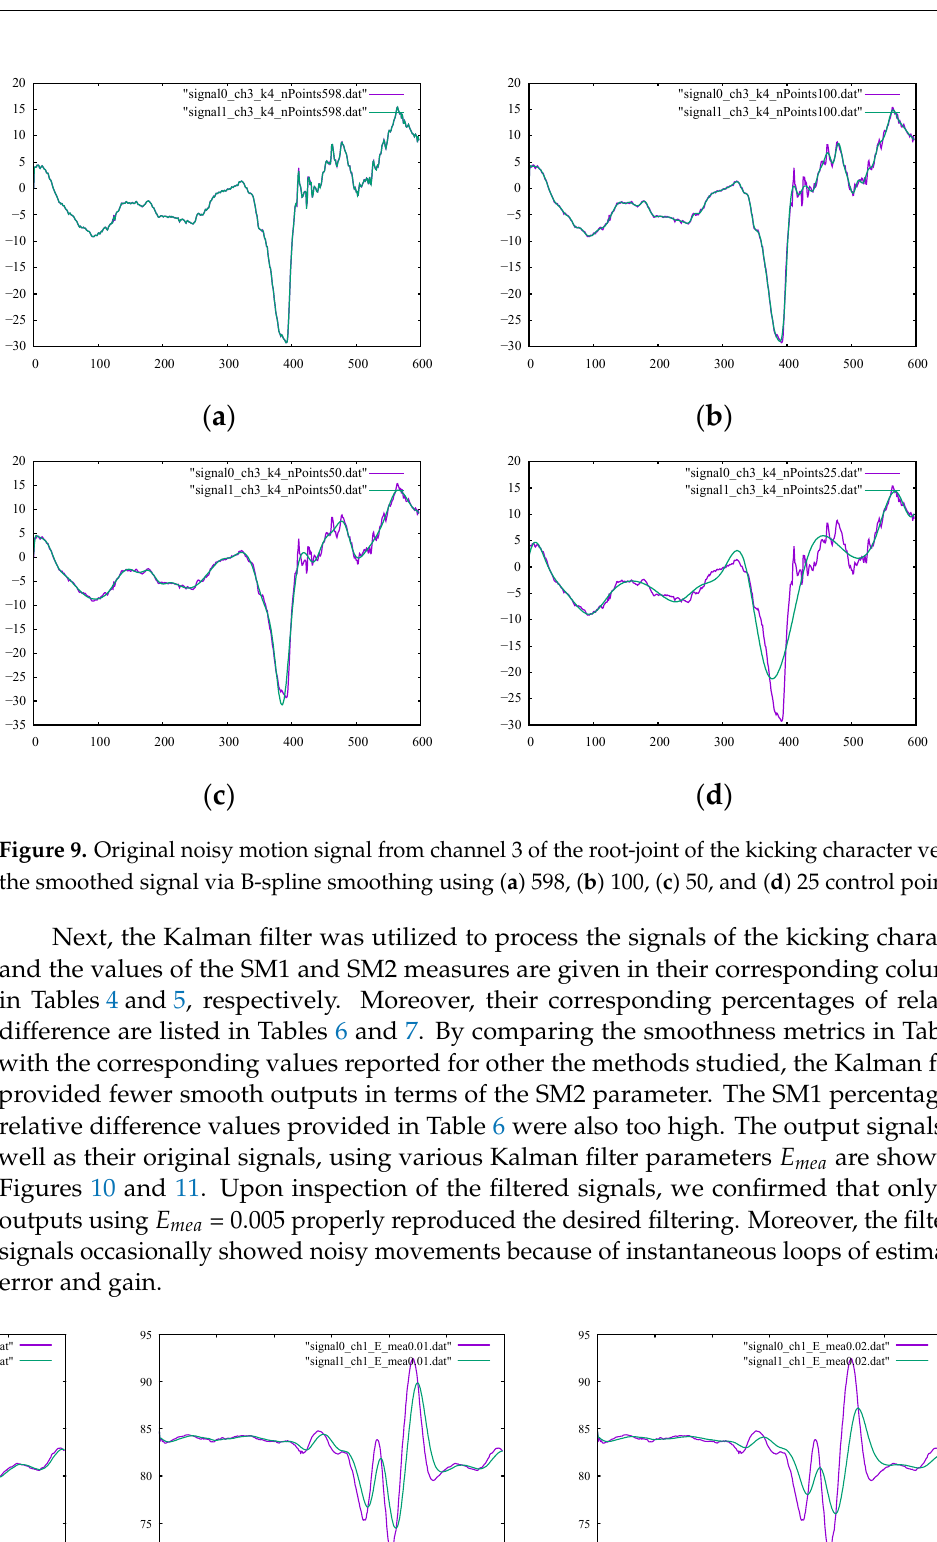
Figure 8. Original noisy motion signal from channel 1 of the root-joint of the kicking character versus the smoothed signal via B-spline smoothing using ( a ) 598, ( b ) 100, ( c ) 50, and ( d ) 25 control points.